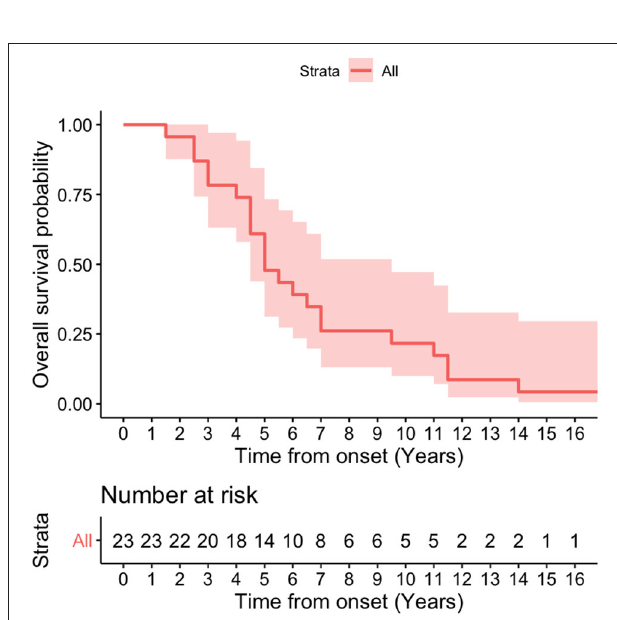
FIGURE 4 | Kaplan-Meier survival curve in all patients. Overall median survival age from the onset to death was 5 years in this cohort.